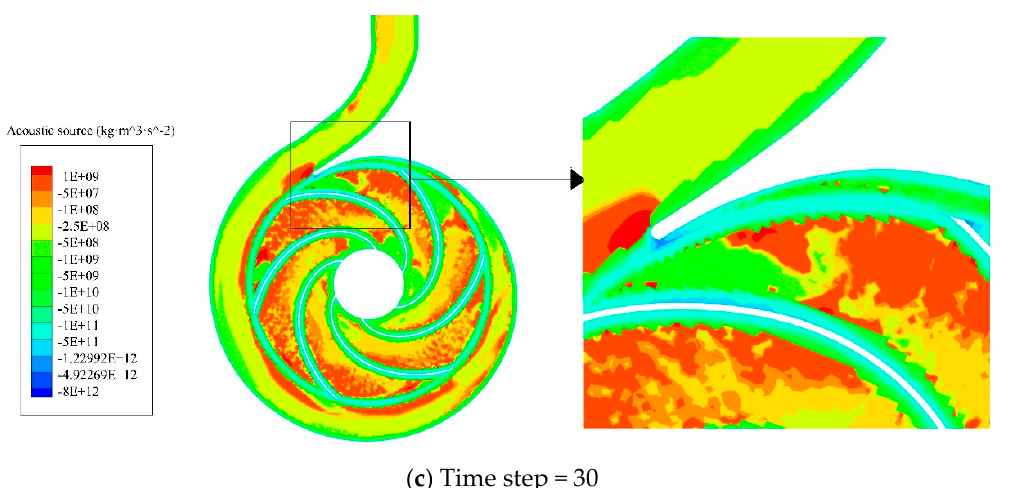
Figure 6. The distribution and evolution characteristics of acoustic source.